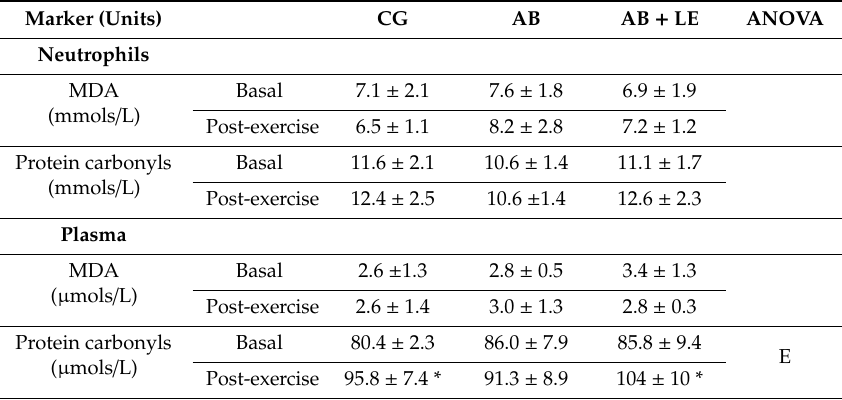
Table 4. Presence of oxidative markers in neutrophils and plasma determined in basal conditions and immediately after the 2000-m test in control (CG), almond beverage (AB) and almond beverage + Lippia extract (AB + LE) groups.